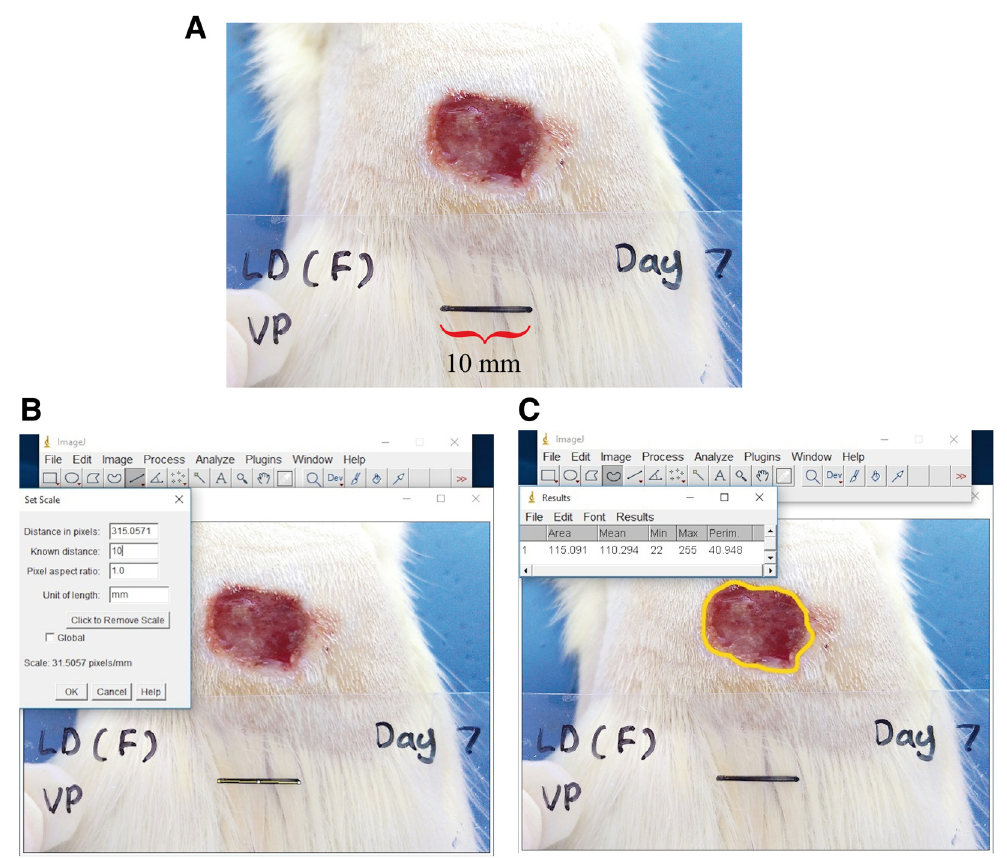
Figure 1. A ) Anaesthetized rat with the scale placed near the wound site, labelled with name, post-wounding day and scale bar of 10 mm for measurement analysis. B ) Calibration of Image J with known distance in image. C ) The outline of the wound is drawn to measure wound